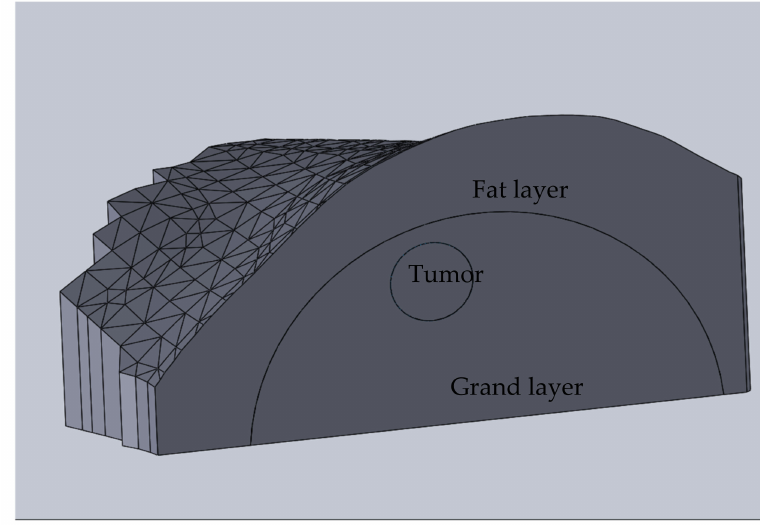
Figure 19. A 3D model with computed parameters (Patient No.